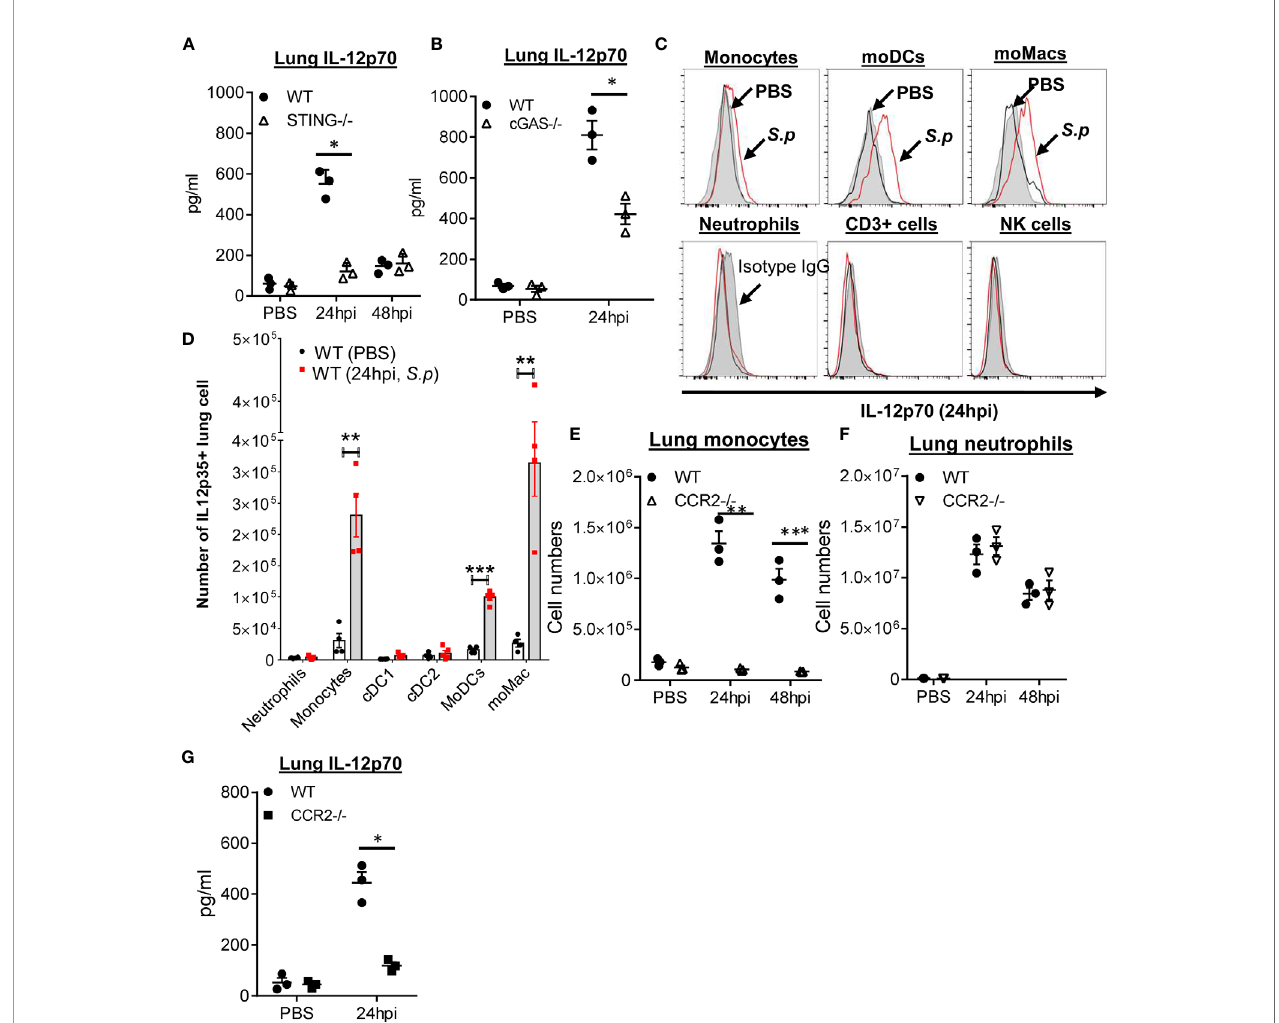
FIGURE 1 | cGAS – STING mediate S. pneumoniae -induced lung IL-12p70 production by monocyte/monocyte-derived cells. (A, B) STING − / − , cGAS − / − , and WT littermates mice were given PBS or infected (i.n.) with S. pneumoniae (D39 strain, ~5 × 10 6 CFU). IL-12p70 (24, 48 hpi) were measured by ELISA (n = 3-4 mice per group). Data are representative of two independent experiments. (C) Flow cytometry analysis of IL-12p70 in lung immune cells from PBS or S. p (~5 × 10 6 CFU) infected C57BL/6J mice at 24 hpi (n = 3 mice per group). Data are representative of three independent experiments. (D) Total cell numbers of IL-12p70 + lung immune cells from (C) were enumerated. (E, F) CCR2 − / − and WT littermates mice were infected (i.n.) with S. pneumoniae as in (A) Total cell numbers of lung Ly6C hi monocyte (E) and neutrophils (F) were enumerated (n = 3 – 4 mice per group). Data are representative of three independent experiments. (G) CCR2 − / − and WT littermate mice were infected with S. pneunoniae as in panel (A) IL-12p70 in lung homogenates (24 hpi) were measured by ELISA (n = 3 mice per group). Data are representative of two independent experiments. Graphs represent the mean with error bars indicating SEM. p -values determined by one-way ANOVA Tukey ’ s multiple comparison test. Signi fi cance is represented by asterisk, where * p < 0.05, ** p < 0.001, *** p <